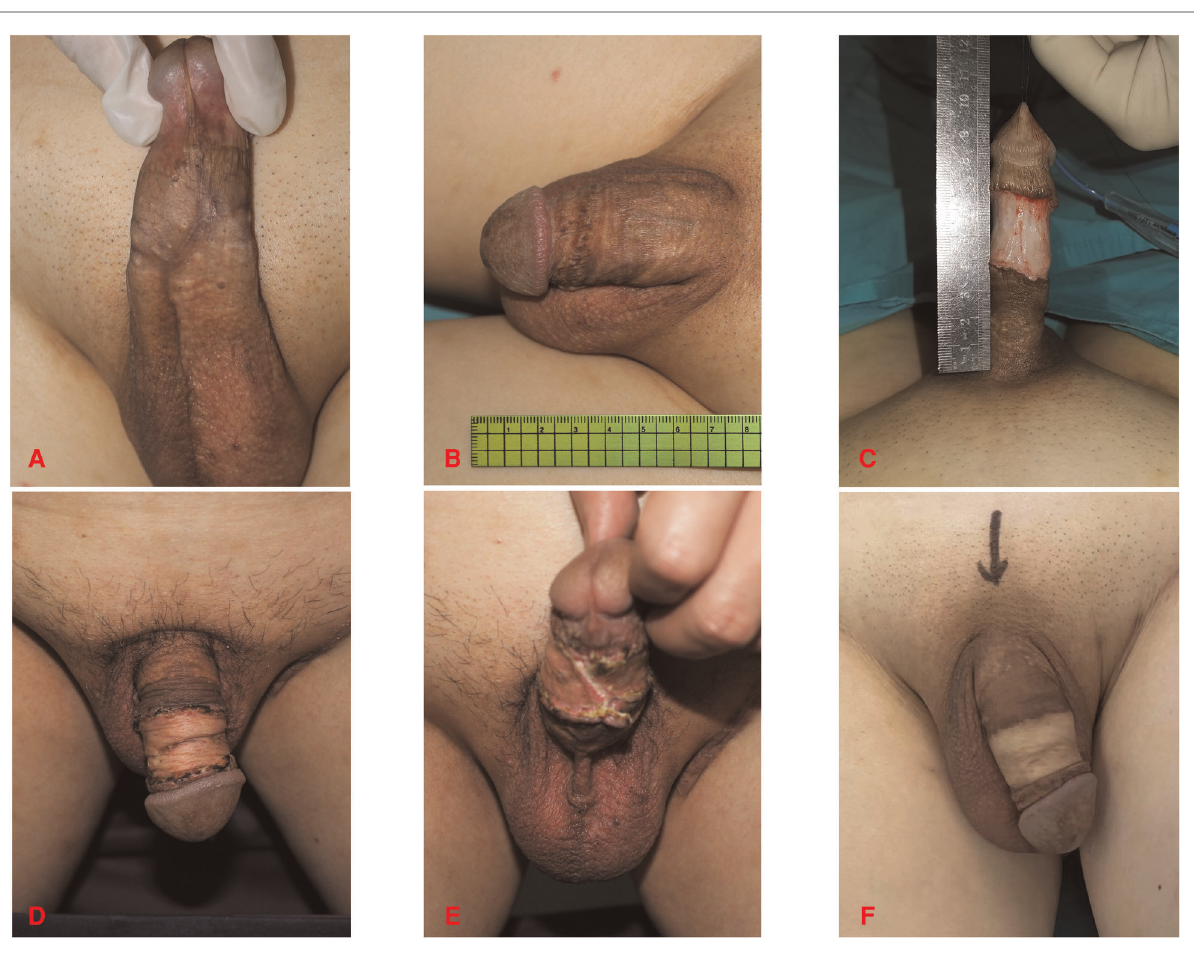
FIGURE 3 47-year-old male. ( A,B ) Preoperative photograph of the penis. ( C ) Incision of the penile skin. ( D,E ) Three months after penial skin grafting from the inguinal region. ( F ) Follow-up at one year after